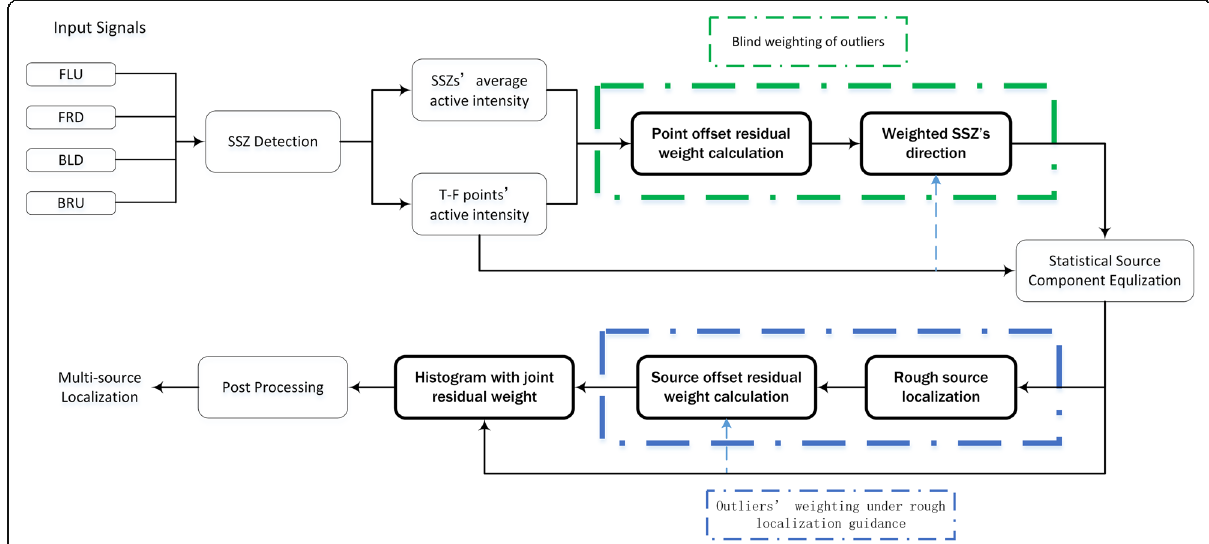
Fig. 4 The block diagram for the proposed multi-source localization